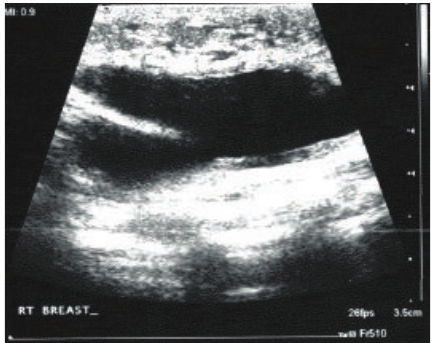
Figure 6: CT of the chest showing several soft tissue lesions noted laterally and anterior to the left pectoralis major measuring 4cm × 3 cm × 1cm.